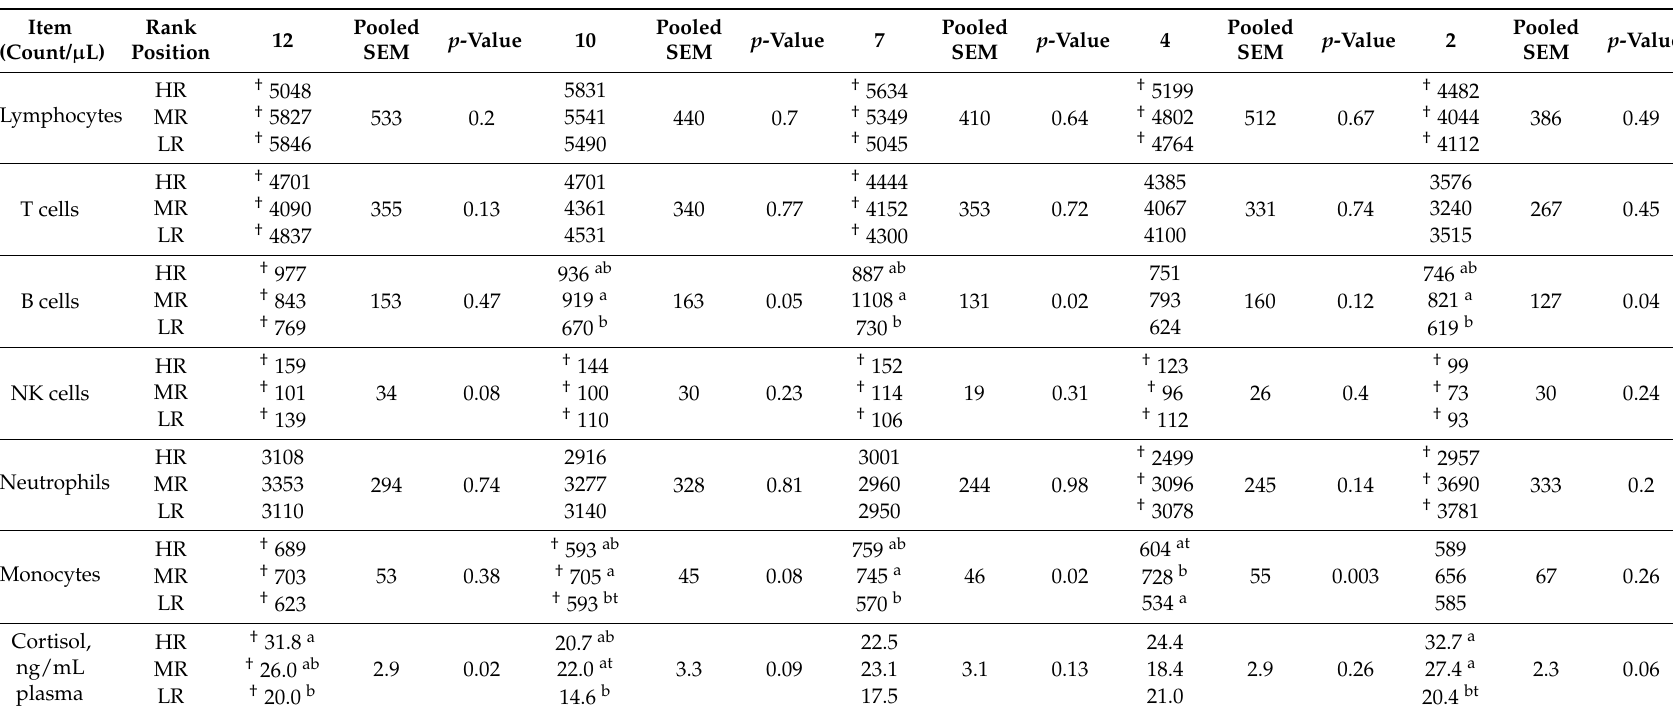
Table 3. Influence of social rank on count of blood immune cells and plasma cortisol concentration in high-ranking (HR), middle-ranking (MR), and low-ranking (LR) pregnant sows at defined weeks pre